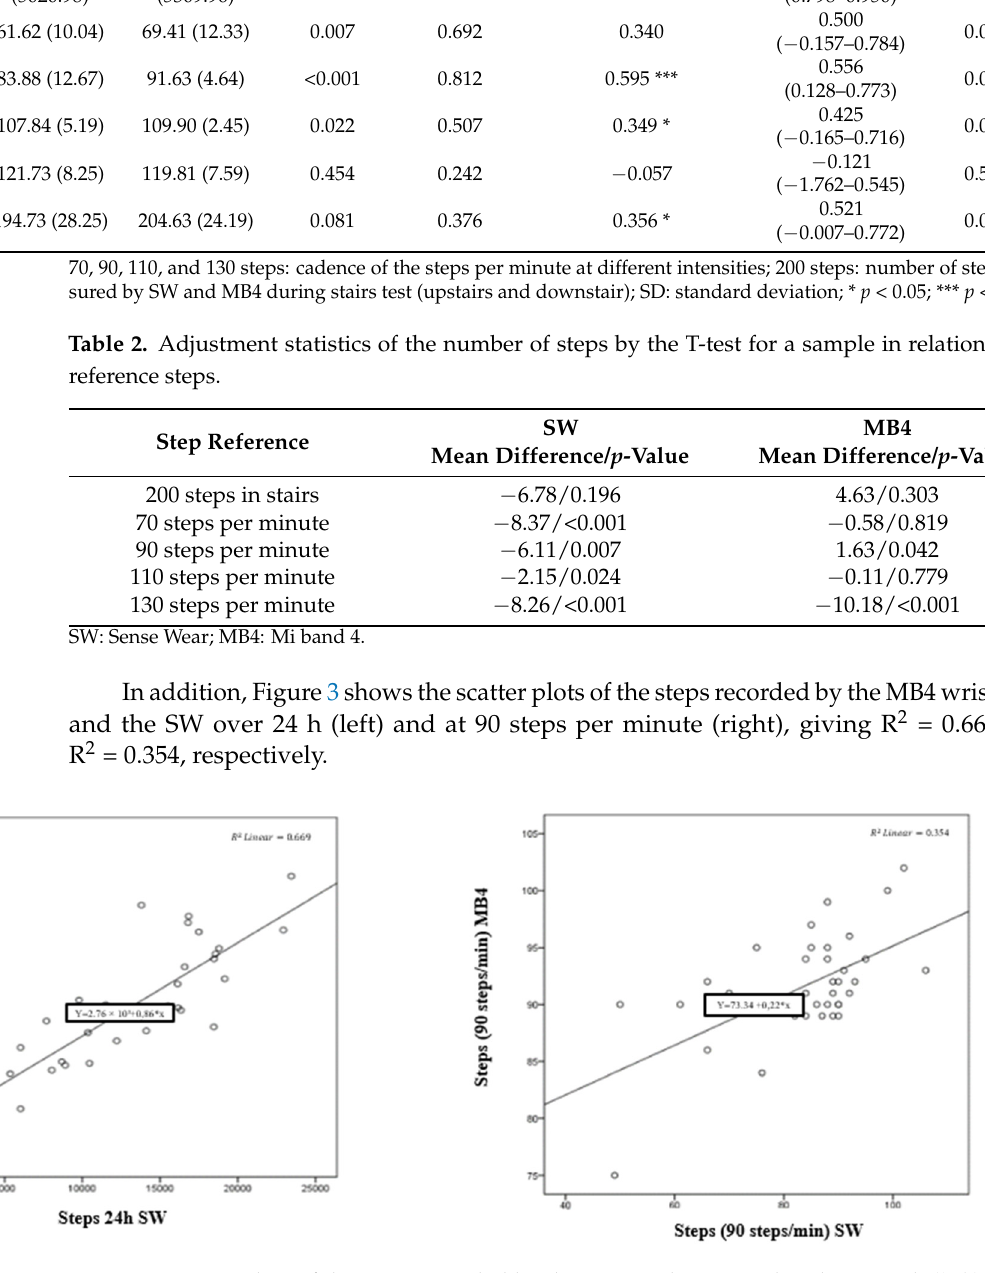
Figure 3. Scatter plots of the steps recorded by the MB4 and SW wristband over 24 h ( left ) and at 90 steps per minute ( right ).